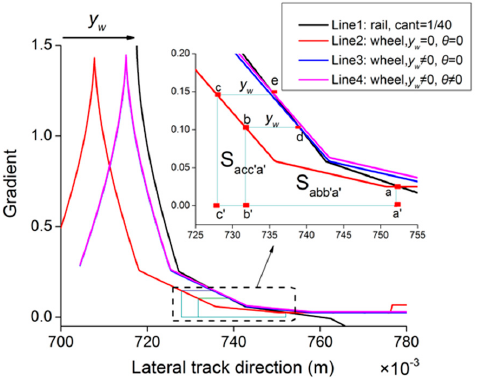
Figure 2. Right wheel-rail contact demonstrated using the wheel-rail profile gradient.